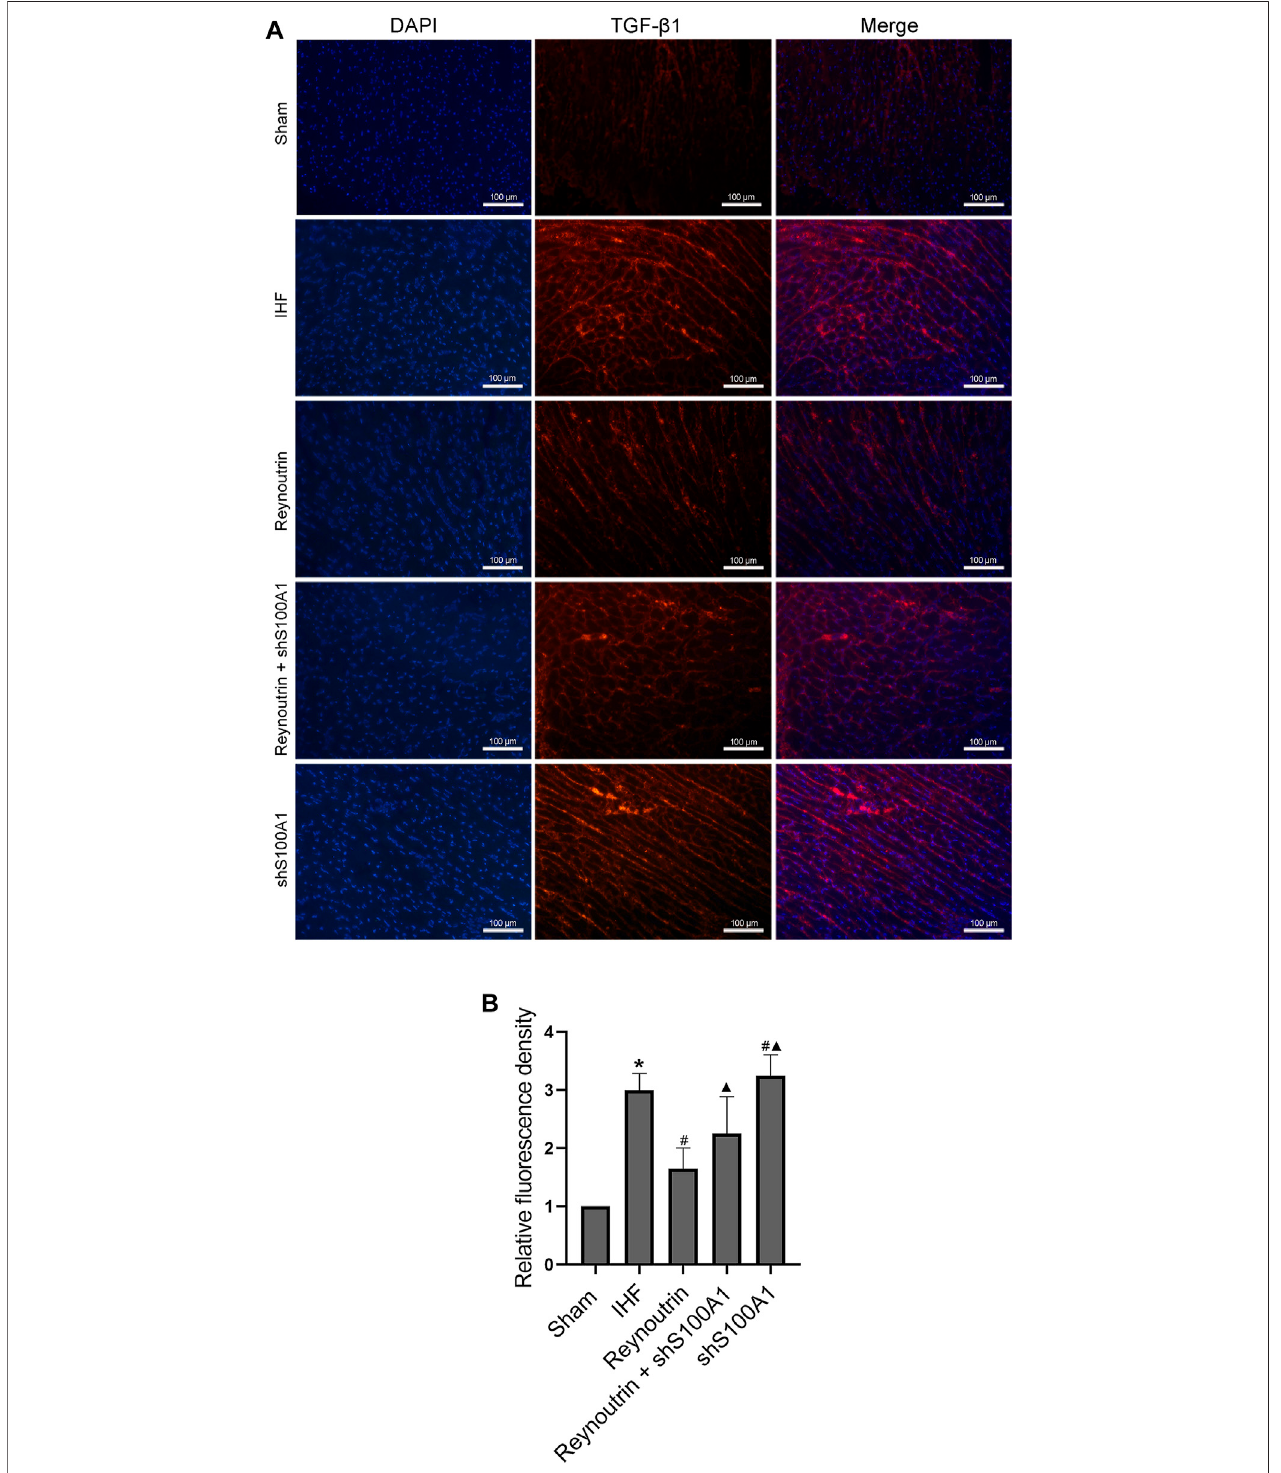
FIGURE 8 | Effects of reynoutrin and S100A1 knock-down on TGF- β 1 expression in paraf fi n sections of myocardial tissues. Immuno fl uorescence staining was used to observe the expression and distribution of TGF- β 1 expression in paraf fi n sections of myocardial tissues. The TGF- β 1 emited red under the red excitation light of fl uorescence microscope. (A) The representative images of immuno fl uorescence staining of each group. (B) The histogram of relative fl uorescence densityineachexperimentalgroup.Thevaluespresentedasthemeans ± standarderrorineachexperimentgroup( n (cid:1) 10).* p < 0.05vs.Shamgroup; # p < 0.05vs. IHF group; ▲ p < 0.05 vs. Reynoutrin group.